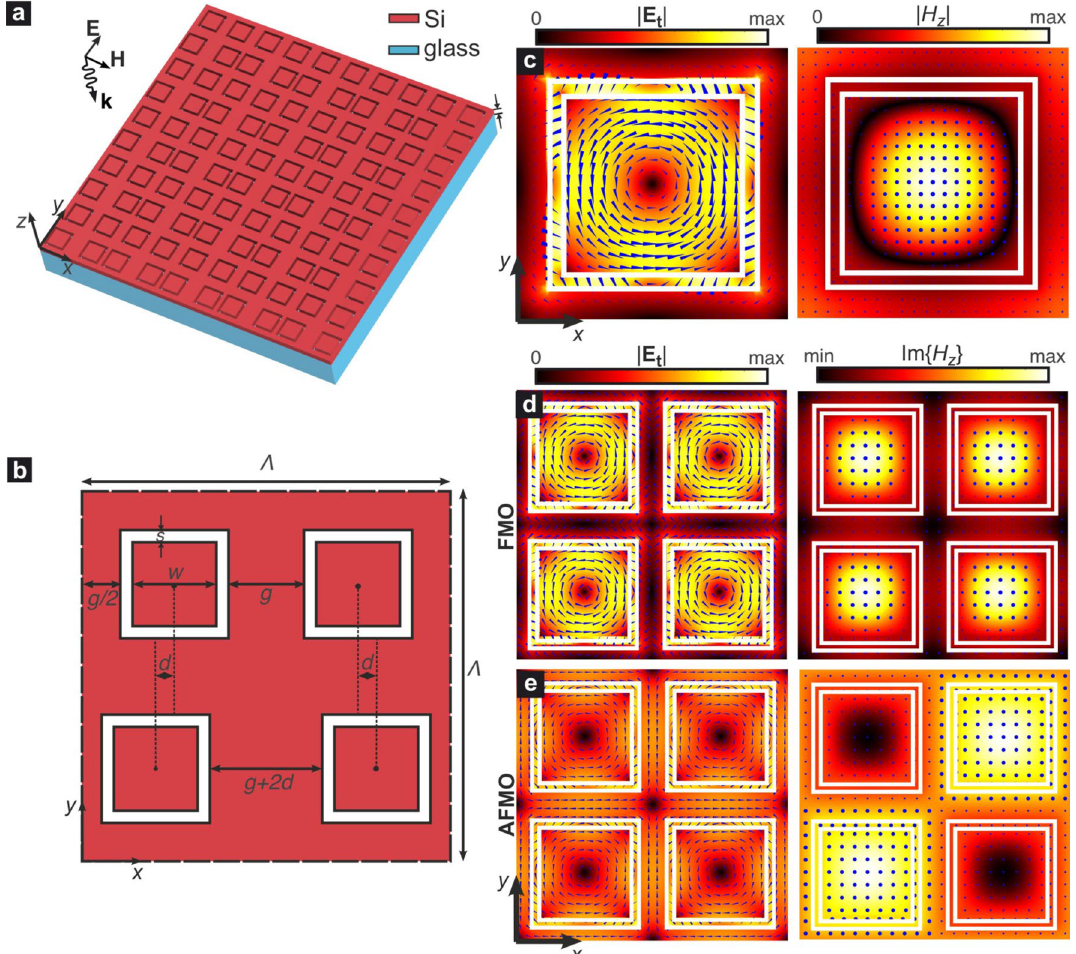
Figure 1. ( a ) Three dimensional layout of the dielectric metasurface of square slotted rings etched in a silicon layer of thickness h . ( b ) Cross-section of the metasurface unit cell composed of four rings, where the centers of the bottom row are laterally displaced towards the edge of the unit cell by a distance d . ( c ) Electric and magnetic field profiles of the circular dark mode supported by the symmetric metasurface, calculated by eigenvalue analysis ( (cid:31) CM res = 1.2627 µ m). ( d ) Field profiles of the symmetric supermode of the four-SSR metasurface unit cell, showing ferromagnetic order ( (cid:31) FMO res = (cid:31) CM res ). ( c ) Field profiles of the antisymmetric supermode of the four- SSR metasurface unit cell, showing antiferromagnetic order ( (cid:31) AFMO res = 1.7311 µ